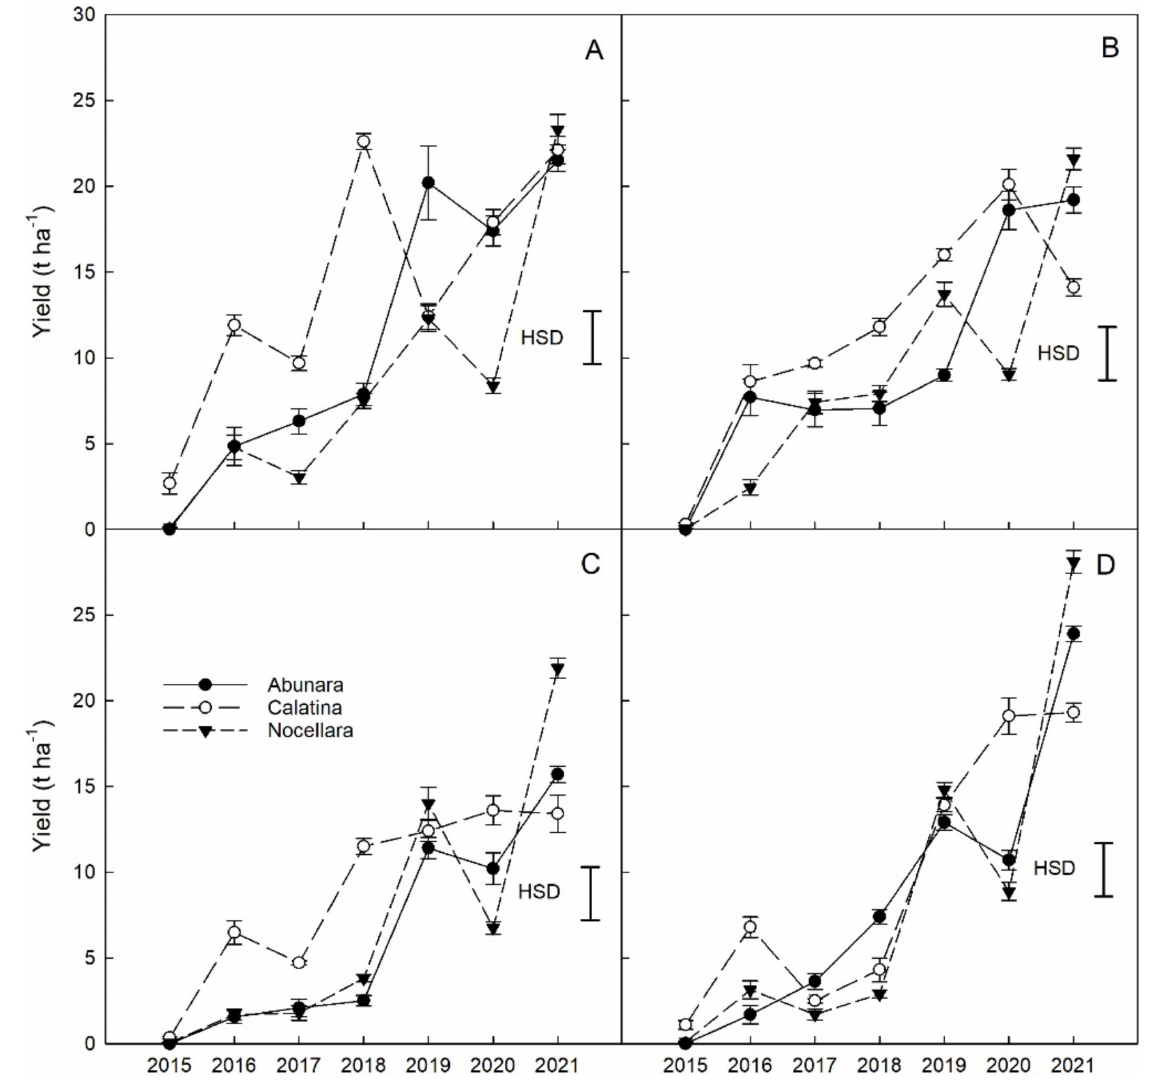
Figure 4. Trends of fruit yield per hectare across the seven years of trial for ‘Abunara’, ‘Calatina’, and ‘Nocellara del Belice’ olive trees grown as central leaders at 2 × 5 m (CLx2, ( A )), free palmette at 3 × 5 m (FPx3, ( B )), globe vase at 4 × 5 m (GVx4, ( C )), and polyconic vase at 5 × 5 m (PVx5, ( D )). Error bars represent standard errors of the means. Mean separation by Tukey’s honestly significant difference (HSD, p <